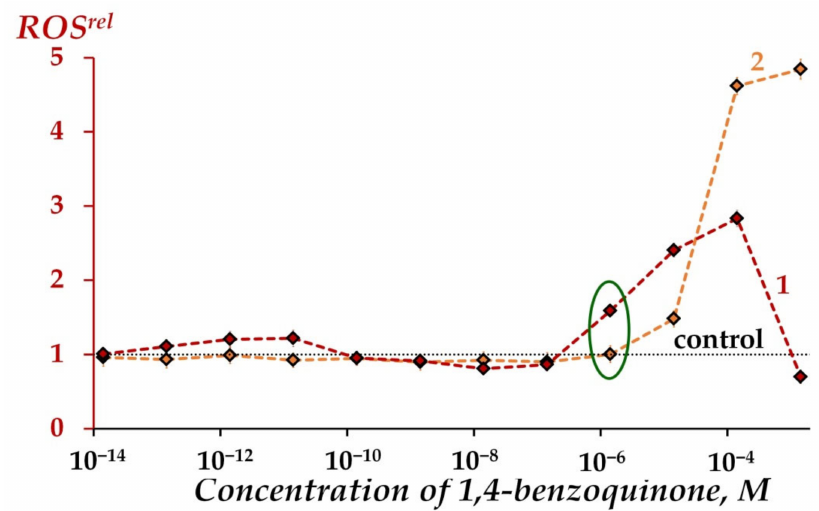
Figure 4. Relative ROS content, ROS rel , in bacterial suspension (1), physiological 3%NaCl solution without bacteria (2) at different concentrations of 1,4-benzoquinone, 5 min exposure. Concentrations of ROS were 1.3 · 10 − 5 M and 4.8 · 10 − 6 M in the control physiological 3%NaCl solution and control bacterial suspension, respectively. Relative ROS content at EC 50 marked with green ellipse. “Control” corresponds to the absence of 1,4-benzoquinone in the experimental